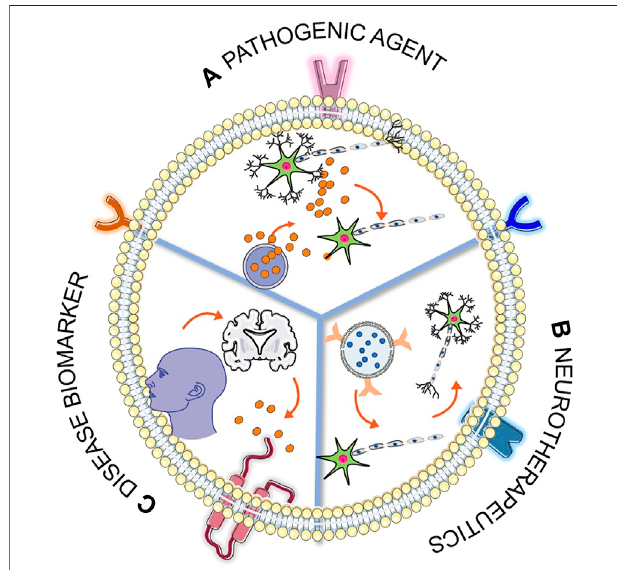
FIGURE 2 | Schematic representation of roles of exosomes in three different fi elds. (A) The blue sphere represents MVB, and the red sphere represents the exosome; this section of the fi gure represents the release of pathogenic cargo from the exosome and subsequent disease transmission. (B) Therapeutic potential of surface engineered cargo loaded exosome and subsequent recovery from disease condition. (C) Exosomes releasedfromthedisease-affectedcellcancrosstheBBBandcanbefoundin blood circulation, which can be utilized in noninvasive biomarker discovery. [Some component of the fi gure is adapted from Servier Medical Art; Servier is licensed under a creative commons attribution 3.0 unported license (https://